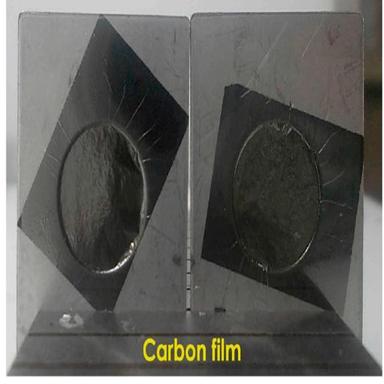
The Carbon film.